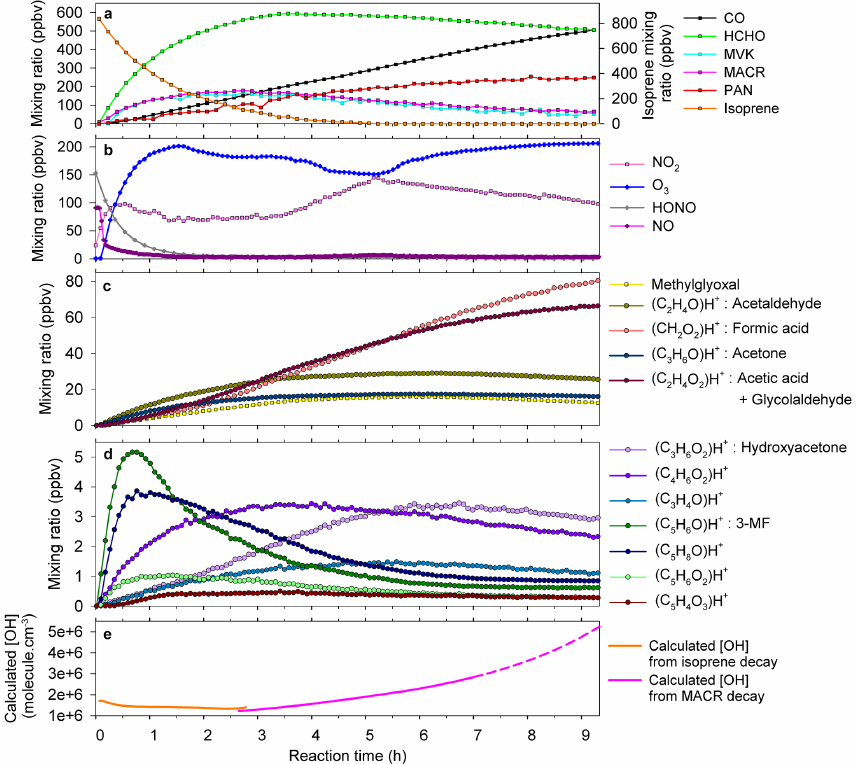
Figure 1. Time profiles of gas-phase measured compounds and calculated OH concentrations during isoprene photooxidation (experiment I280113) performed with no seeds and with HONO as OH source. PTR-ToF-MS measurements are represented by circles, and FTIR mea- surements, by squares. Calculated [OH] is represented by a dotted line after 7h of irradiation due to low MACR mixing ratios which implies less precision in the calculation as the contribution from other VOCs is not